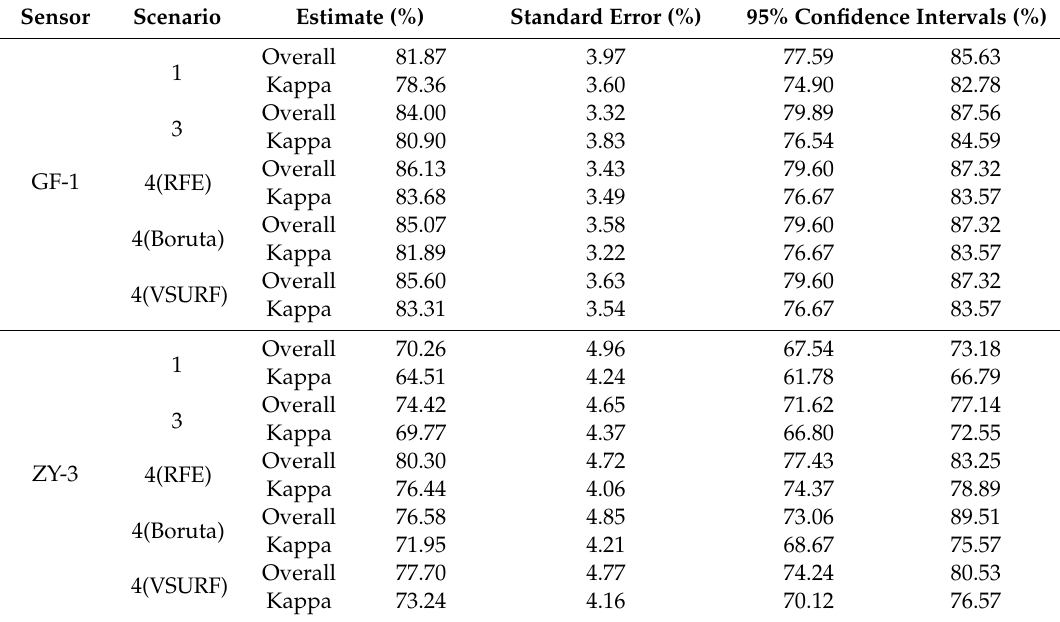
Figure 11. Comparison of scenarios 1, 3, and 4 (RFE) classifications results of GF-1 and ZY-3 data. A: forest; B: cropland; C: deep-water herbaceous vegetation; D: shallow-water herbaceous vegetation; E: paddy field; F: shrub; G: open water. Table 10. Accuracy assessment of RF models for di ff erent classification scenarios using testing